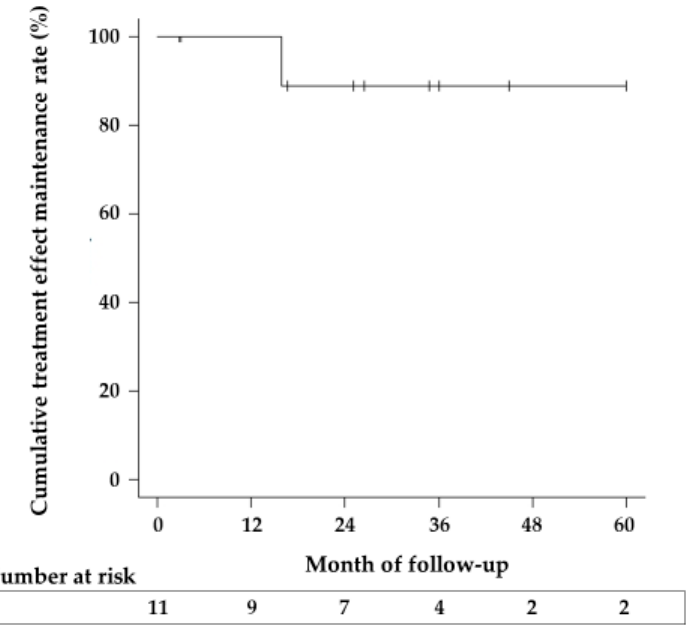
Figure 2. Cumulative treatment effect maintenance rate. The cumulative treatment effect maintenance rate for patients treated with POEM (peroral endoscopic myotomy) was 100% at 1 year, and 88.9% at 2 and 3 years, respectively.